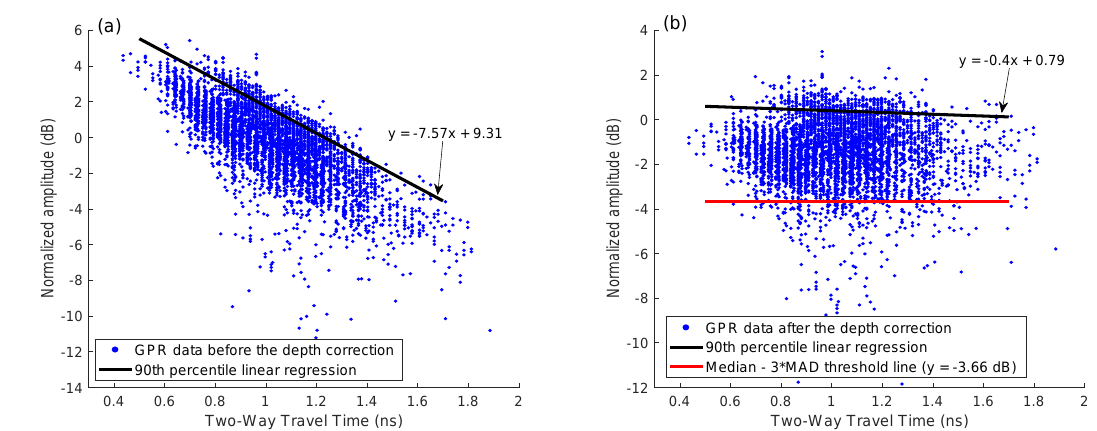
Figure 13. Scatter plot of GPR data points from the curved bridge ( a ) before and ( b ) after amplitude- depth correction, and threshold